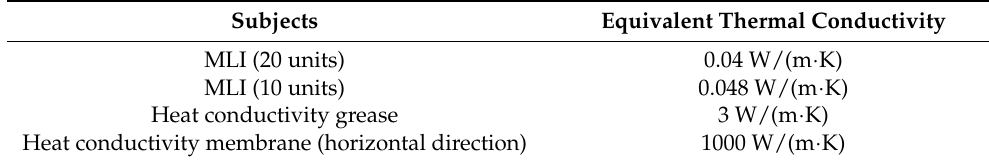
Table 5. Equivalent thermal conductivity of MLI and heat conduction